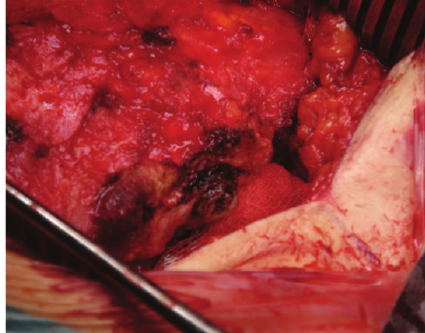
Figure 4: Inferior soft tissue dissection exposing the tip of the coccyx.